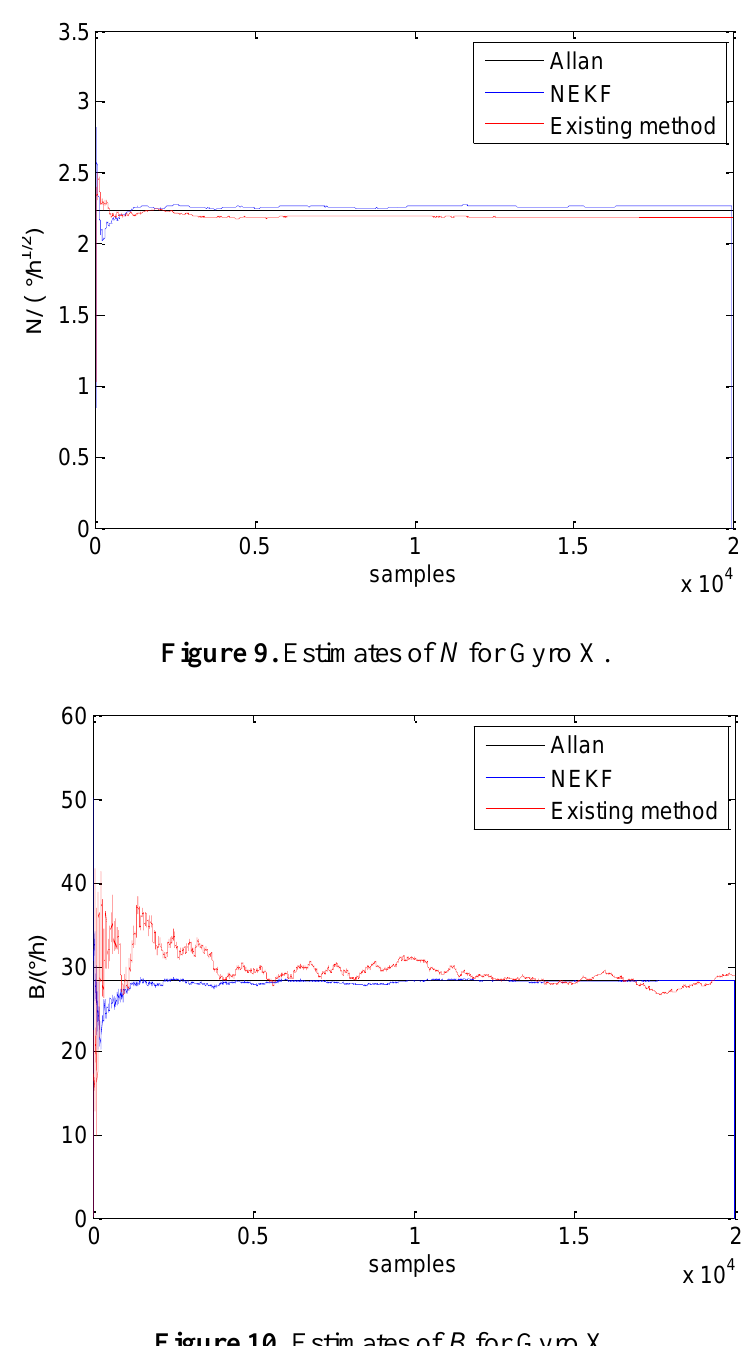
Figure 10. Estimates of B for Gyro